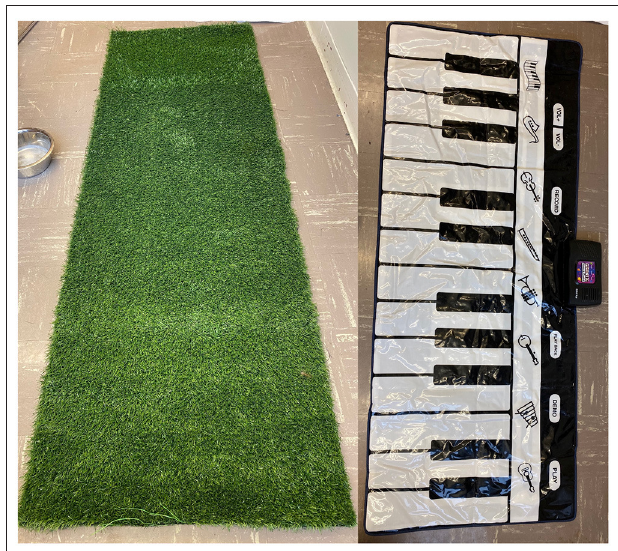
FIGURE 1 | Examples of the artificial grass and floor piano used for sensory-modified exercises.